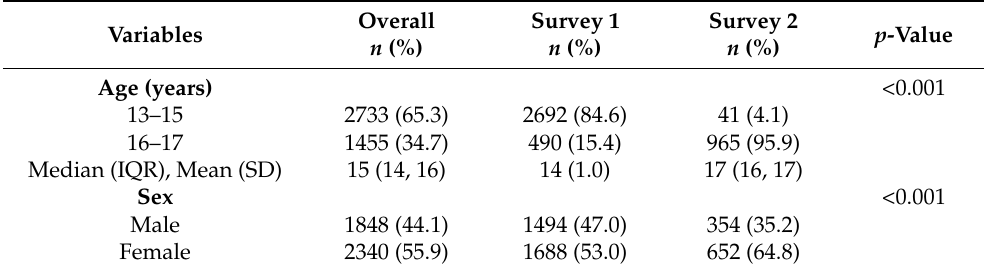
Table 1. Sociodemographic and behavioral characteristics of secondary school-going adolescents from two repeated RSHS in 2019 and 2022 in Kilimanjaro region, northern